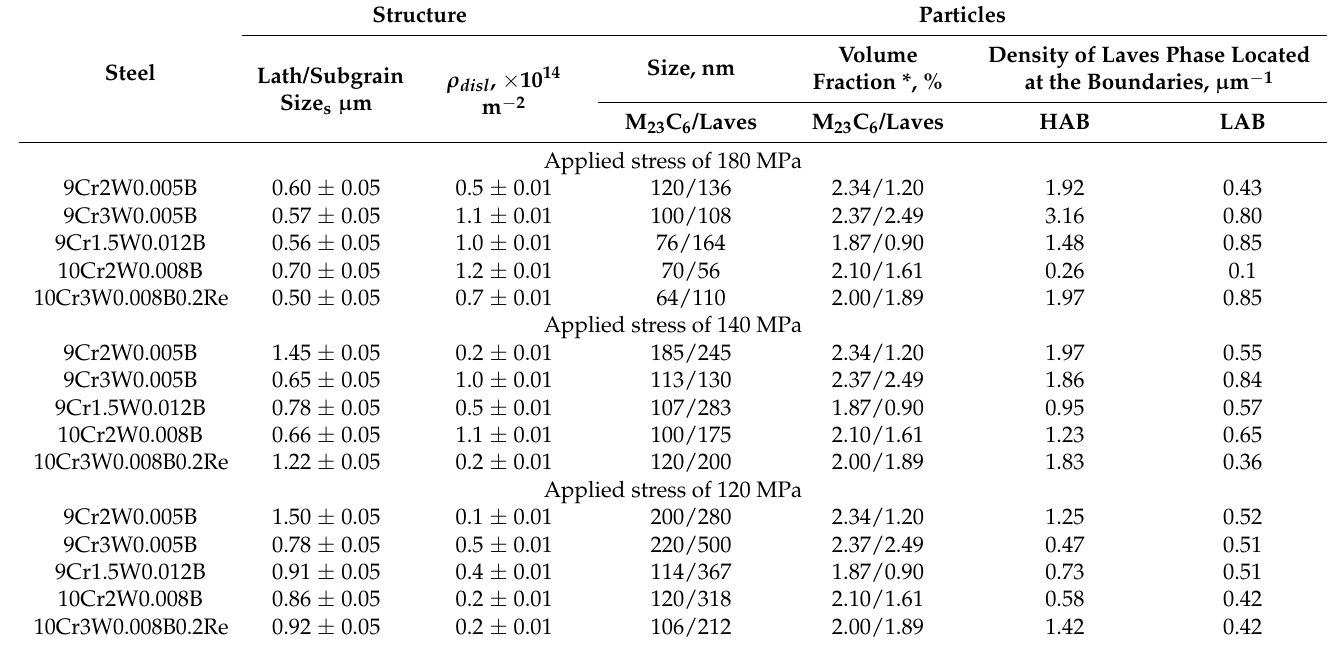
Table 4. Structural parameters after creep tests up to rupture in the gauge